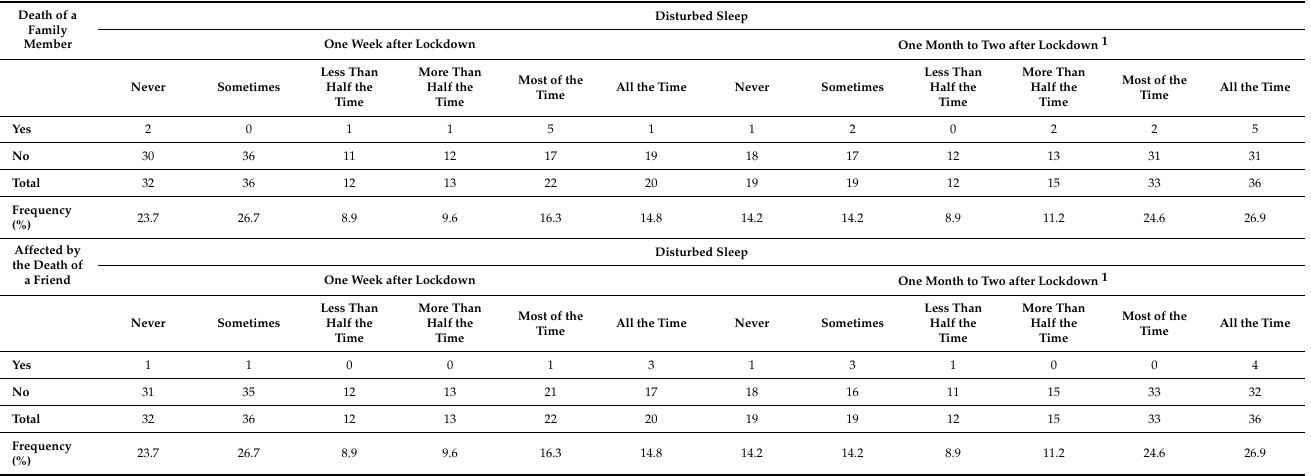
Table 4. Disturbed sleep and death of a family member/friend.